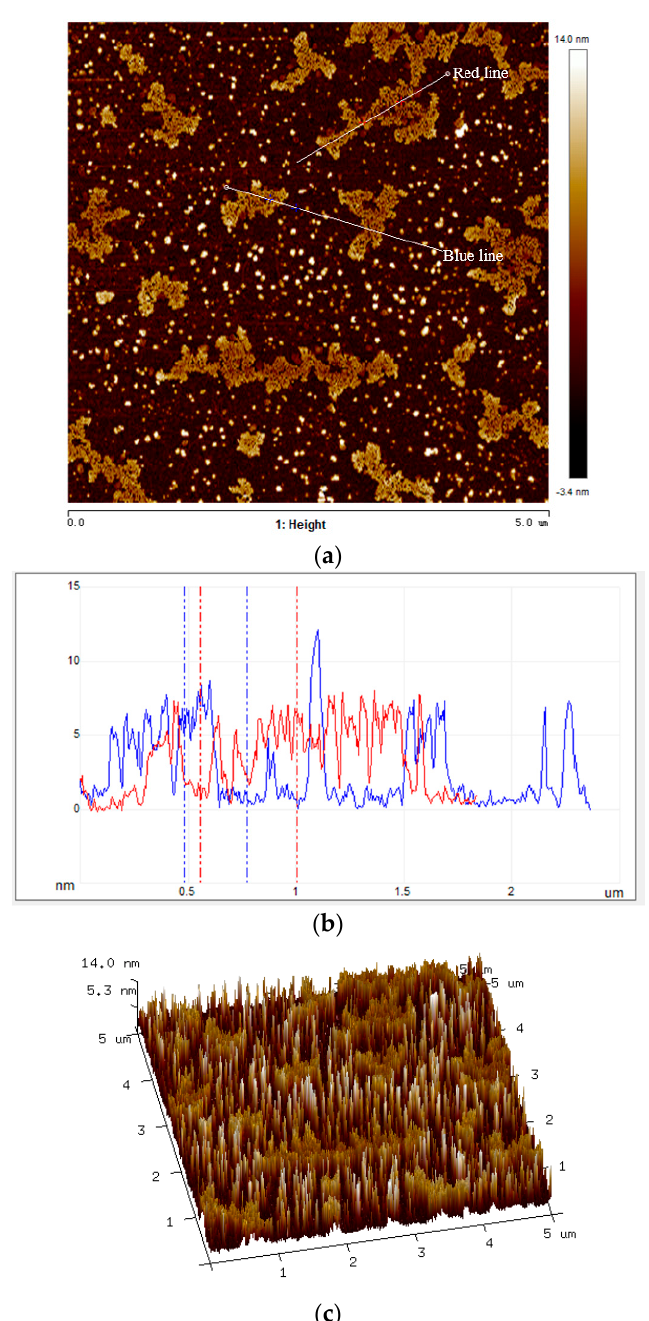
Figure 7. Tapping mode image of atomic force microscopy (AFM). ( a ) AFM Image of graphene (scan size: 5 × 5 μ m); ( b ) Cross sections of two different directions; ( c ) Surface morphology of graphene by AFM 3D image.